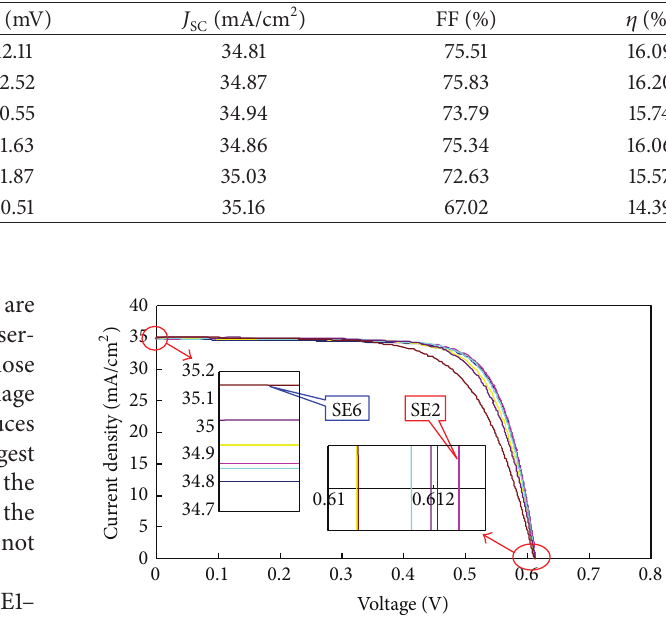
Table 2: Solar-cell performance parameters of six SE samples with different heavily doped sheet resistance ( 𝑅 ), fabricated using one-step POCl resistance ( 𝑅 SL